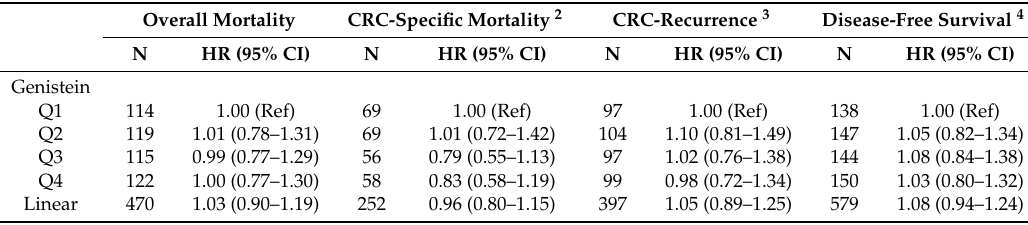
Table 2. Association of serum genistein and luteolin concentrations with long-term outcomes in CRC patients 1